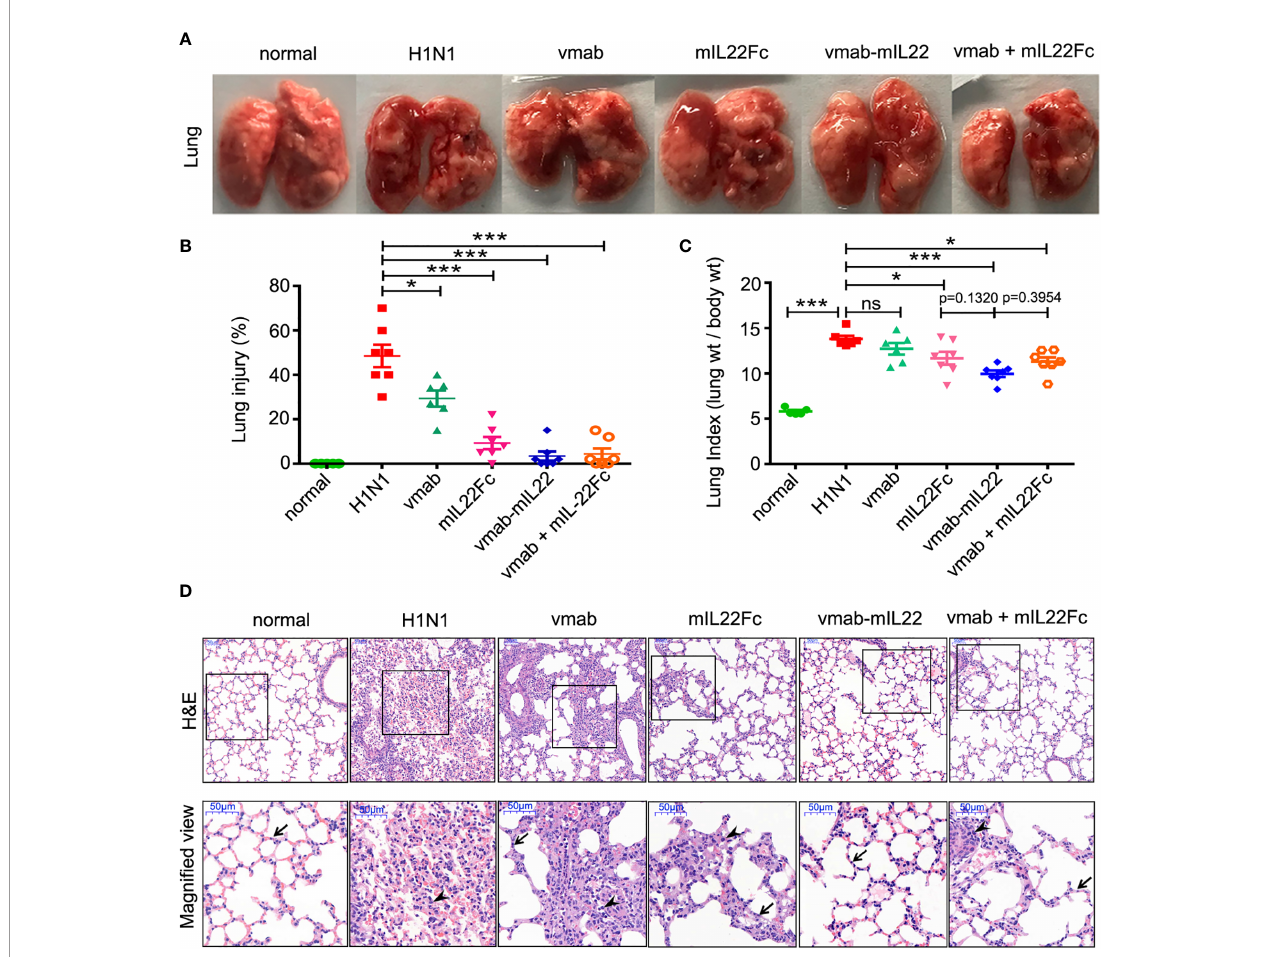
FIGURE 4 | The therapeutic ef fi cacy of vmab-mIL22 against H1N1-induced lung immune injury. (A) Representative pulmonary edema showing the pathology of the lung. (B, C) Assessment of the therapeutic effect of vmab-mIL22 on pulmonary edema and lung index scores H1N1 infection, compared with saline, vmab, mIL22Fc, the combination of vmab and mIL22Fc and healthy mice. Mice were randomly divided into six groups. There are seven mice in each group (n = 7). Values were expressed as mean ± SEM. Multiple group comparisons were performed using one-way analysis of variance (ANOVA) followed by Bonferroni post hoc test using the software of SPSS. p-value of less than 0.05 was considered to be signi fi cant. (D) Representative histological sections of the lung tissues from H1N1 virus-infected mice receiving each therapy or saline treatment were stained with hematoxylin and eosin. Bars, 50 m m. Wedge indicates accumulation of mononuclear cells, and black arrow indicates the alveolar wall. *P < 0.05 or ***P < 0.001. NS, not signi